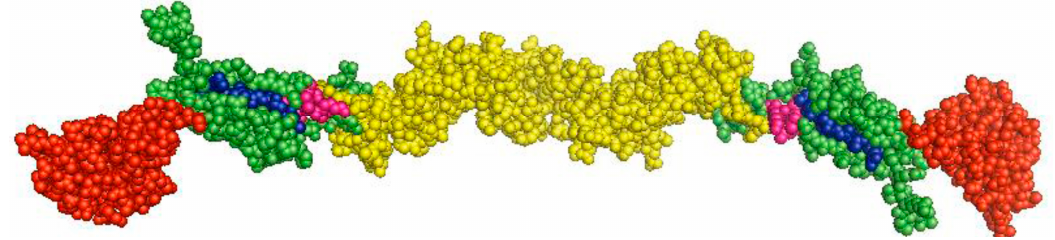
Figure 2. Predicted three-dimensional structure of the CSFV E2 protein. Homology modeling analysis of the CSFV E2 protein was performed using the software PyMOL 1.7 according to the structure of the BVDV E2 protein. Domains B/C are shown in red, domains D/A in green, the other region in yellow, and the fusion peptides (FP1 and FP2) of E2 in blue or purple.